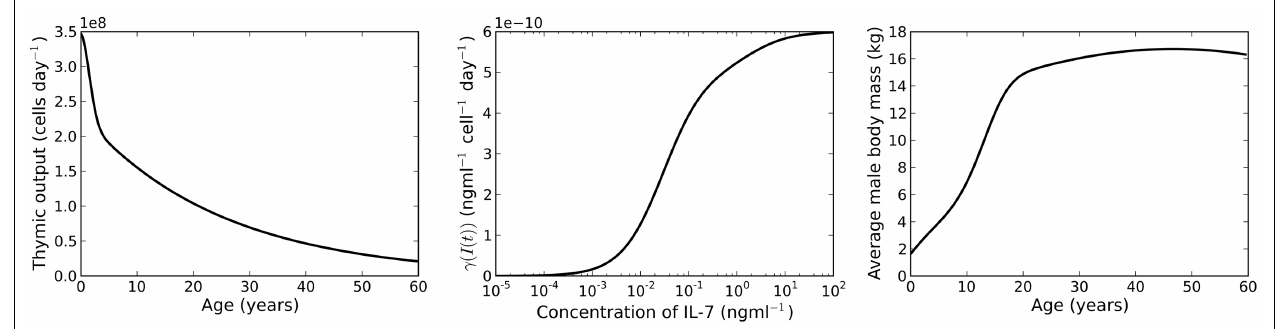
FIGURE 2 | Left panel: rate of thymic export . Plot of equation (8). Middle panel: IL-7 internalization rate. Plot of the function γ ( I ( t )). Right panel: plot of the function m ( s ) (equation (11)), a model for the average body mass of male